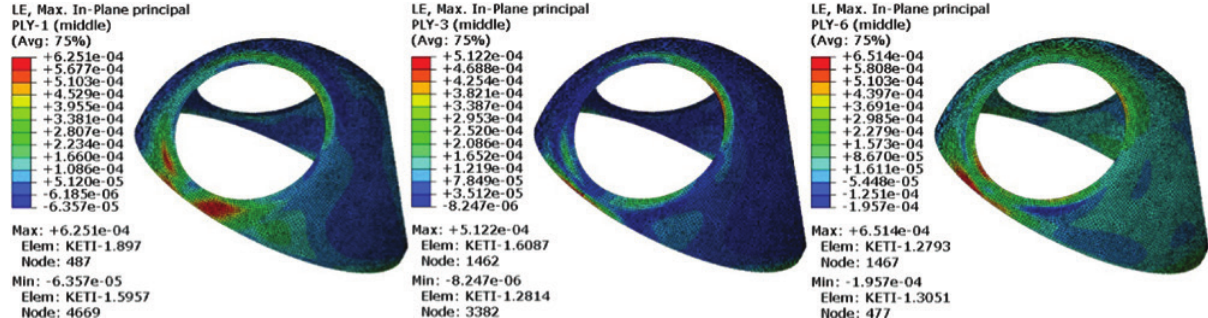
Figure 6: Strain nephogram of spherical shell’s first, third, and sixth layers (compression